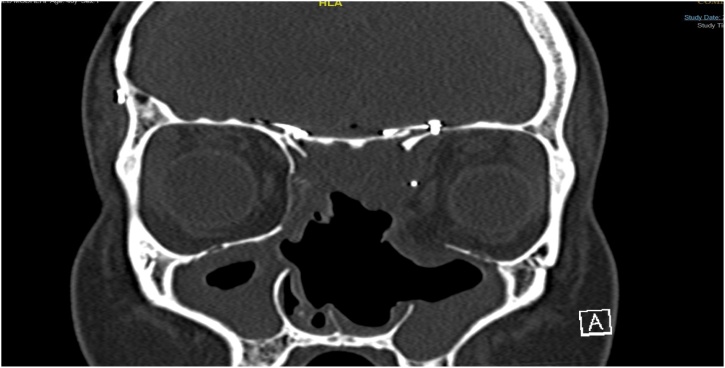
Postoperative CT.